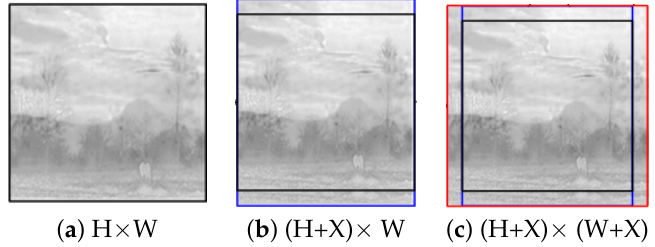
Figure 6. The extent of color separation image.